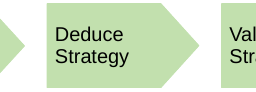
Figure 1. Overview of the